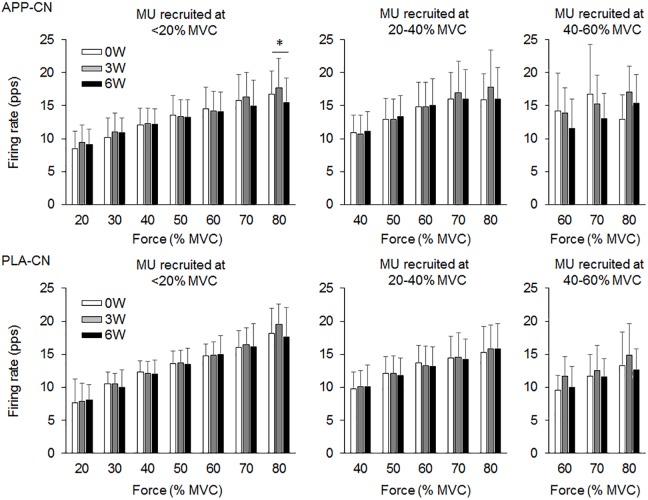
Motor unit firing rates of the group with fish protein intake (APP-CN) and the group with the placebo (PLA-CN). MU, motor units. The symbol ∗ indicates significant differences (p < 0.05) among the periods.